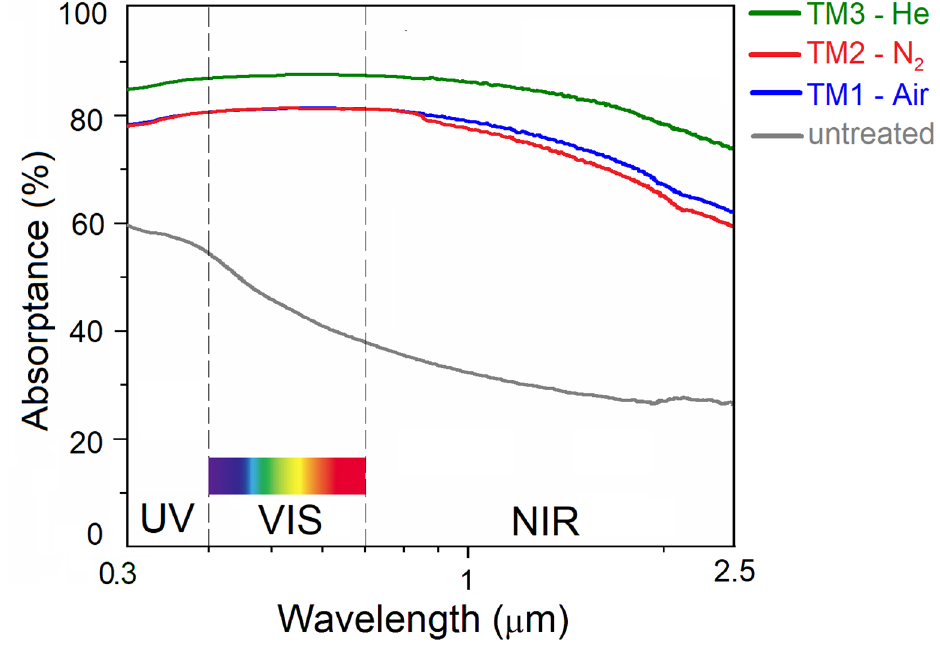
Figure 5. Absorptance spectra of the three black diamond films laser-treated under different gas environments, obtained by spectrophotometric analysis according to Equation (1). For comparison, the absorptance spectrum of an untreated sample (gray curve) with the same crystalline quality is shown.